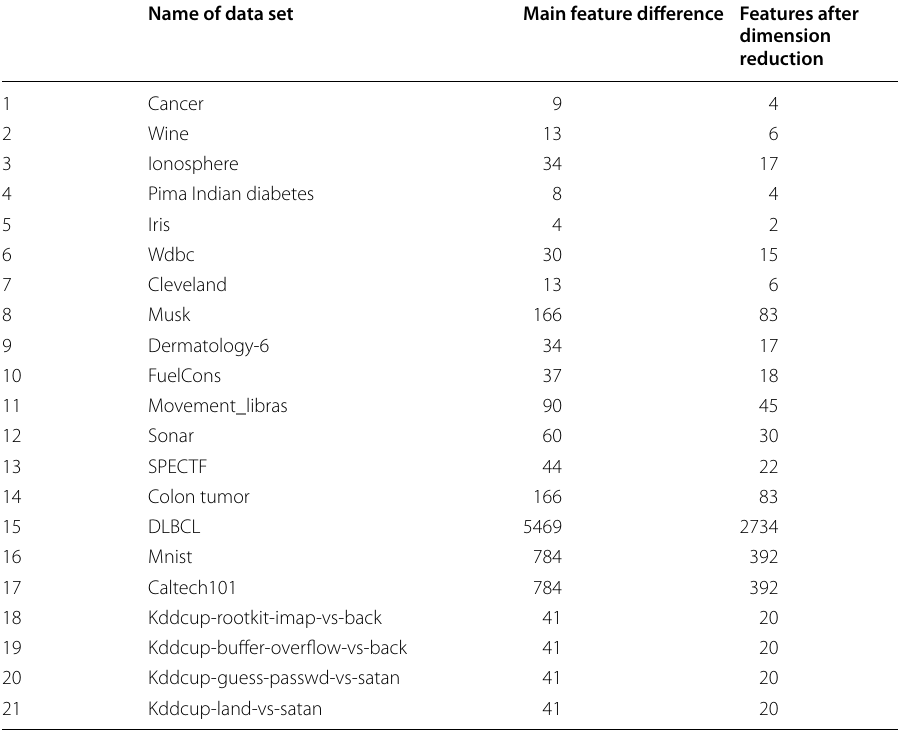
Table 3 The number of original features and the number of features after dimension